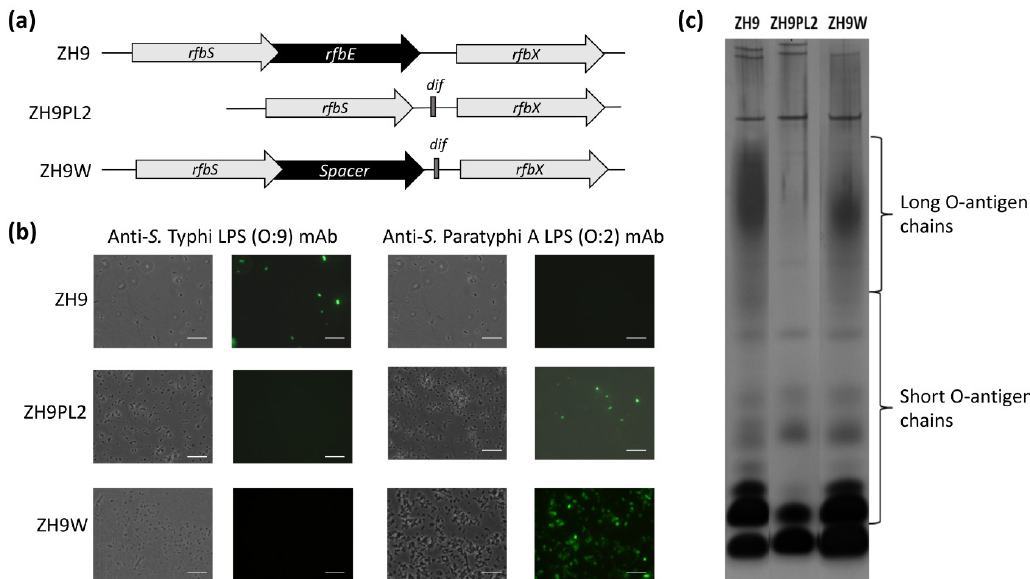
Figure 2. Modifying LPS (O:9) to LPS (O:2). ( a ) Part of the wild-type O-antigen locus from S. Typhi ZH9 was modified using two test approaches: by deleting the majority of the rfbE cistron to generate S. Typhi ZH9PL2 or by replacing the rfbE cistron with a spacer DNA sequence to maintain the original reading frame to generate S. Typhi ZH9W. ( b ) Fluorescence microscopy images showing the parental S. Typhi ZH9 and derivative strains, ZH9PL2 and ZH9W, probed with anti- S. Typhi LPS (O:9) or anti- S. Paratyphi A LPS (O:2) monoclonal antibodies followed by Dylight 488 secondary antibodies; the left column images are phase contrast images and the right column images are immuno-fluorescence micrographs. Images were taken at 100 × magnification. Scale bars represent 10 µ m. Representative images based on three independent experimental repeats. ( c ) Silver-stained polyacrylamide gel of LPS extracts from the parental S. Typhi ZH9 and derivative strains, ZH9PL2 and ZH9W, indicating the short and long O-antigen chains. LPS = lipopolysaccharide; mAb = monoclonal